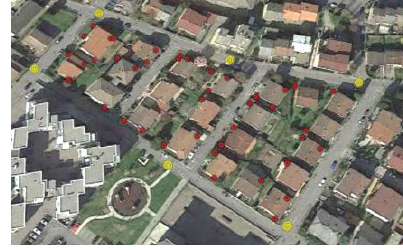
Figure 2. The residential area selected for the kinematic test. The selected GCPs are represented in red, while the GPS pseudo-observations in